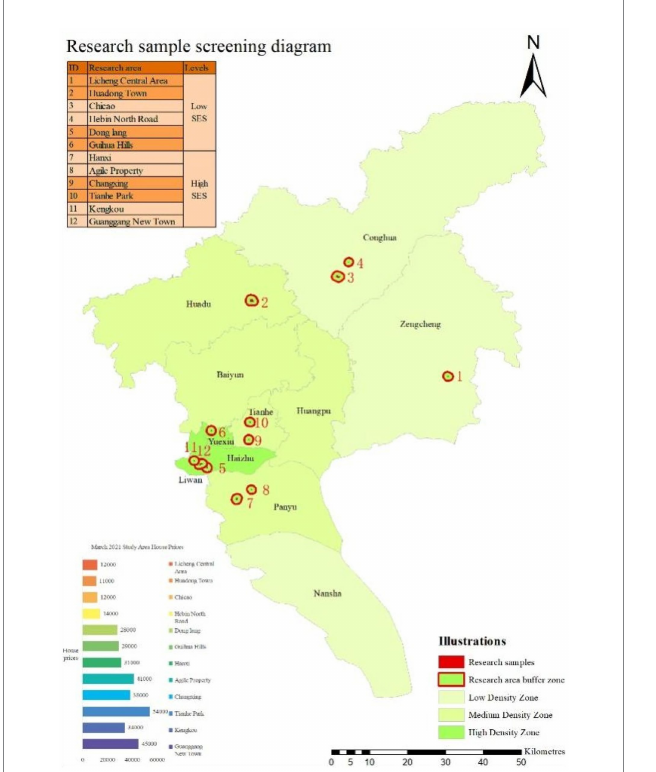
FIGURE 1 Research sample screening diagram.